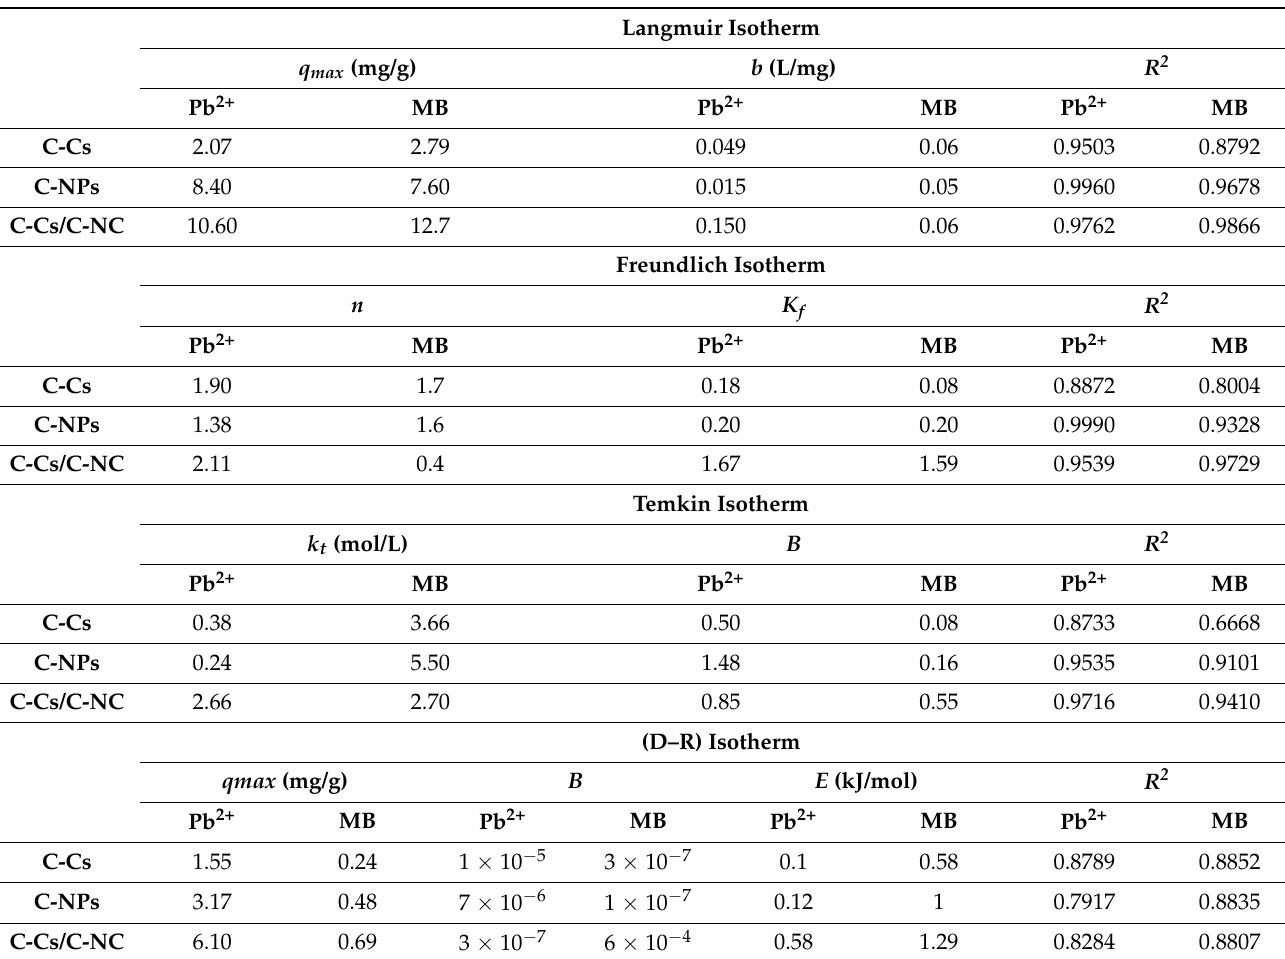
Table 3. Parameters of isotherms for Pb 2+ and MB removal onto C-Cs, C-NPs, and C-Cs/C-NC. Langmuir